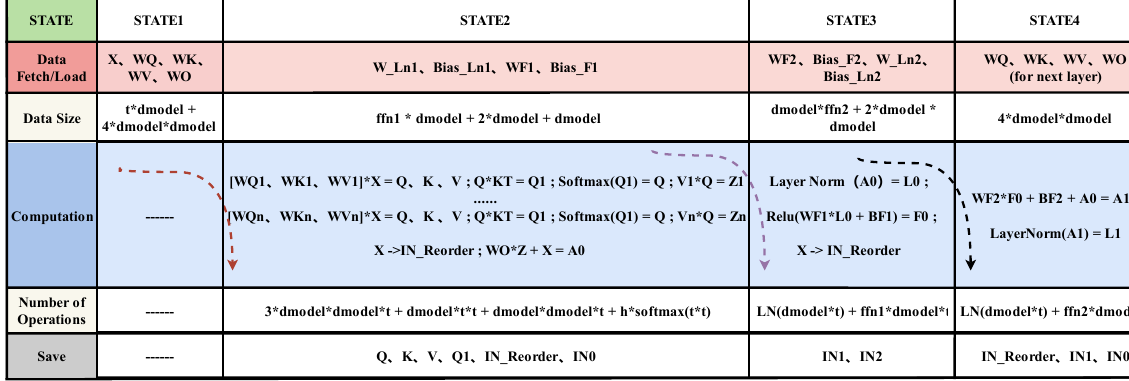
Figure 9. The control flow of the EFA-Trans. Data fetch is colored in pink, and the computation process is colored in